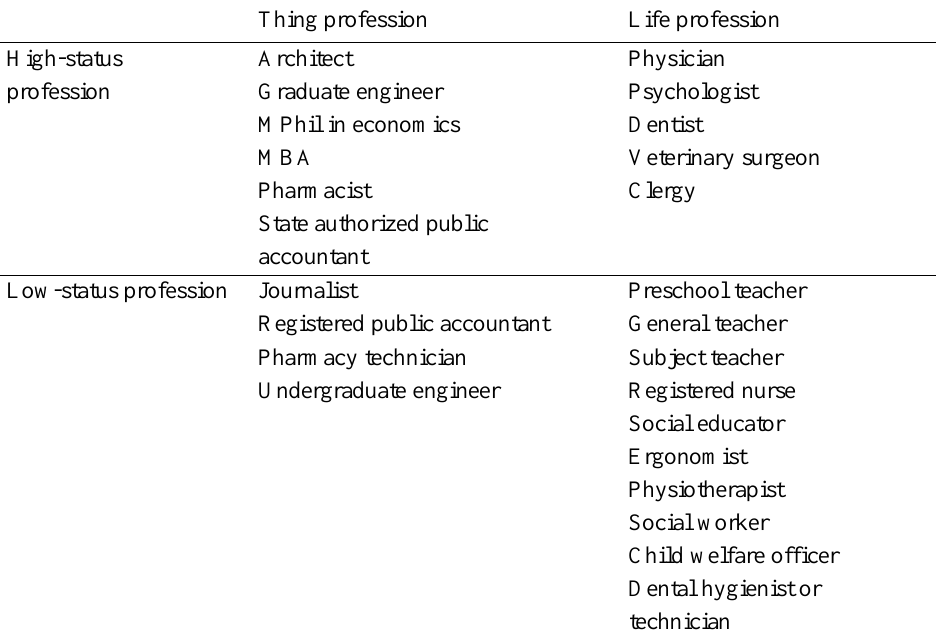
Classification of